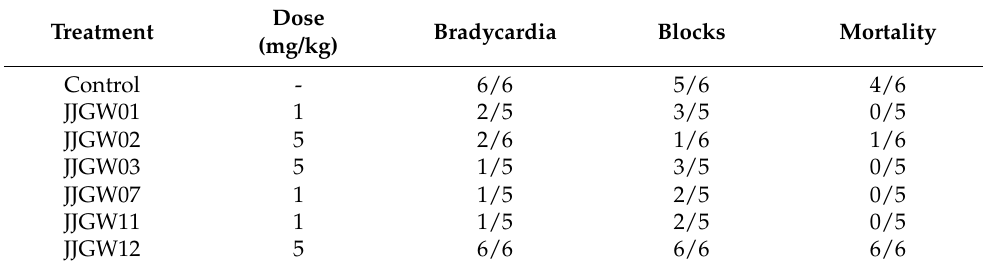
arrhythmogen. The electrocardiogram (ECG) recordings were performed for 15 min. Results are